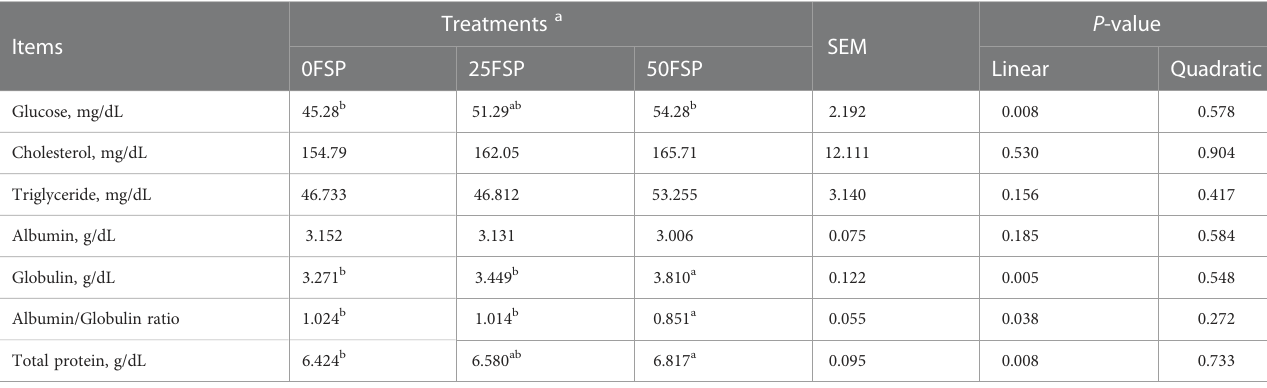
TABLE 4 Blood parameters of early lactating Holstein dairy cows (n = 8 per treatment) fed a basal diet supplemented with fennel seed powder (FSP).